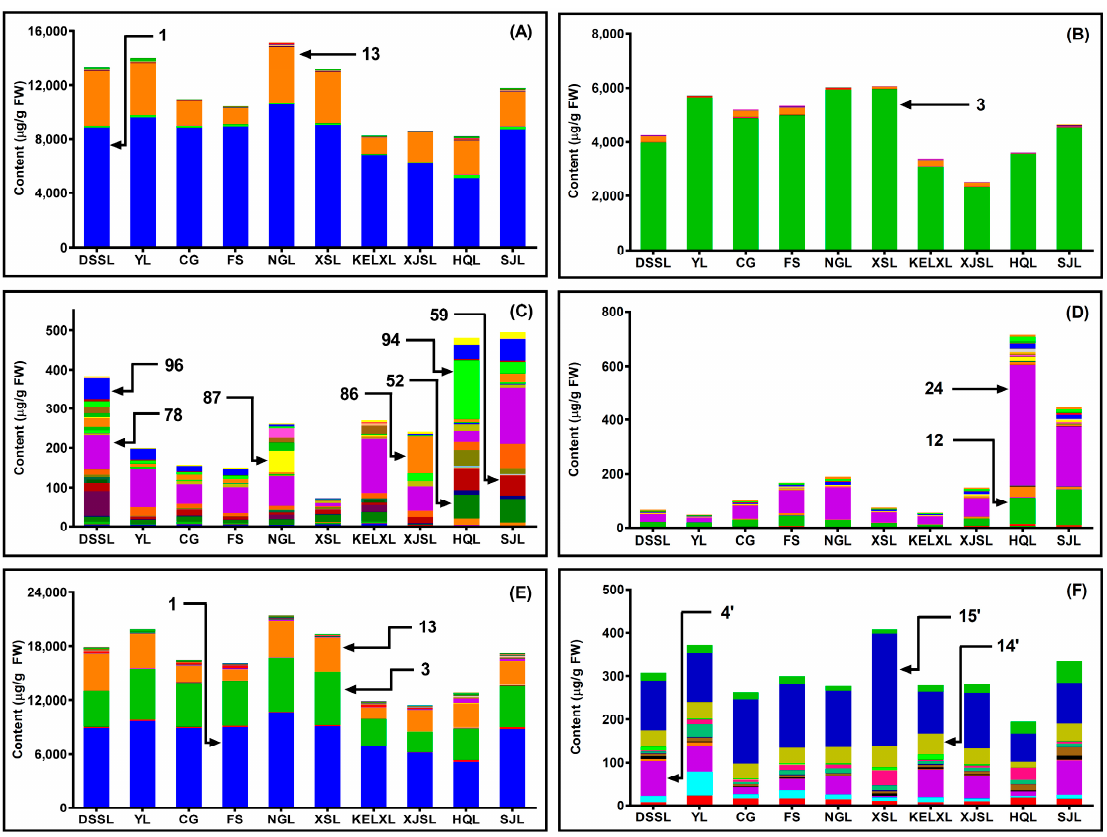
Figure 2. The content of chemical constituents in thinned young pears. ( A ) 28 phenolic acids, ( B ) 16 phenolic glycosides, ( C ) 33 flavones, ( D ) 25 flavan-3-ols and procyanidins, ( E ) total polyphenloic compounds, ( F ) 16 triterpenoids. (1) quinic acid; (3) arbutin; (12) (+)-catechin; (13) chlorogenic acid; (24) ( − )-epicatechin; (52) rutin; (59) quercetin-3 -O- glucoside; (78) isorhamnetin-3 -O- rutinoside; (86) isorhamnetin-3 -O- glucoside; (87) kaempferol-3 -O- glucoside; (94) kaempferol-acylated-galactoside; (96) isorhamnetin-acylated-glucoside; (4´) pomolic acid isomer; (14´) oleanolic acid; (15´) ursolic acid.